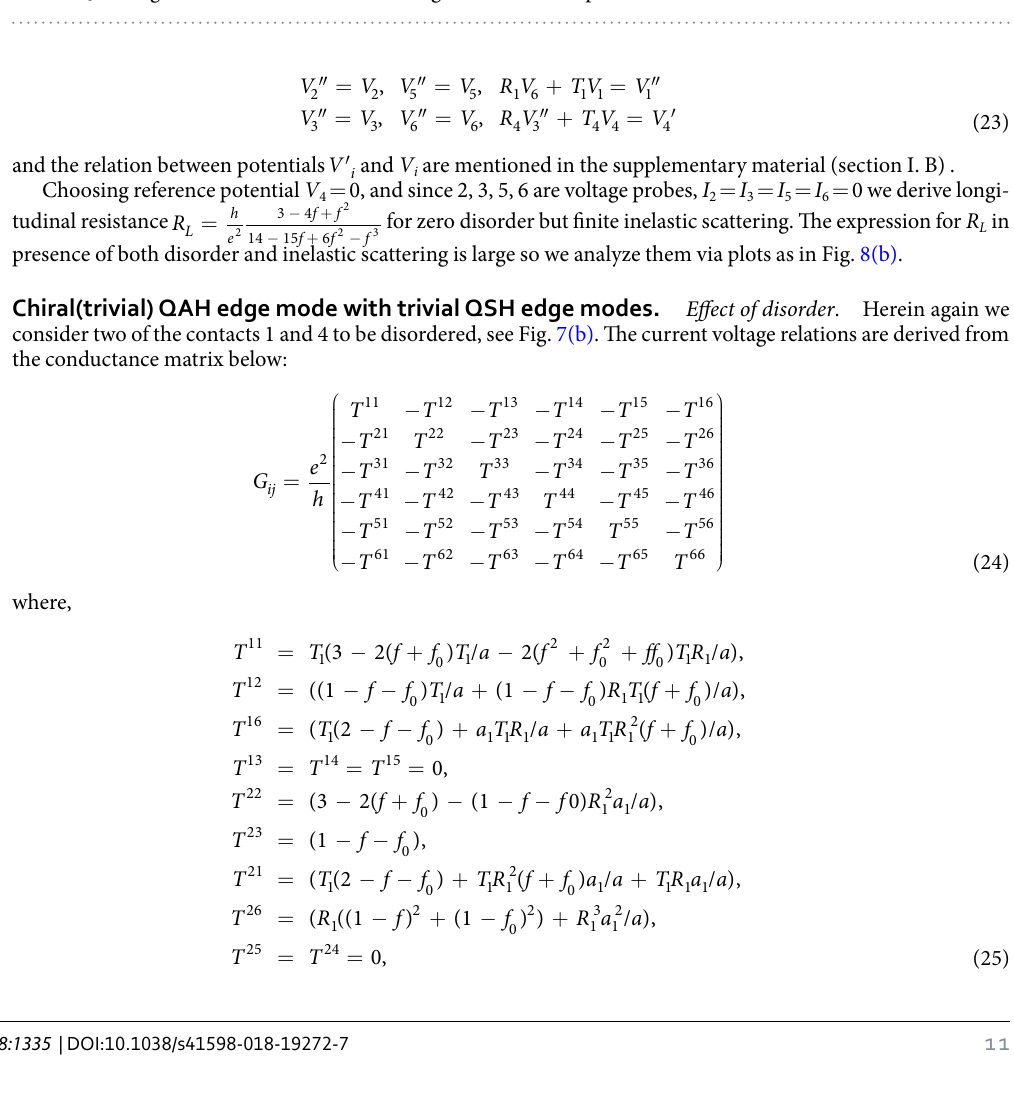
Figure 7. 6 terminal topological and trivial QAH edge mode along-with quasi-helical QSH edge modes. ( a ) Topological QAH edge mode with disorder at probes 1 and 4, ( b ) Trivial QAH edge mode with disorder at probes 1 and 4, ( c ) Topological QAH edge mode with inelastic scattering and disorder at probes 1 and 4, ( d ) Trivial QAH edge mdoe with inelastic scattering and disorder at probes 1 and